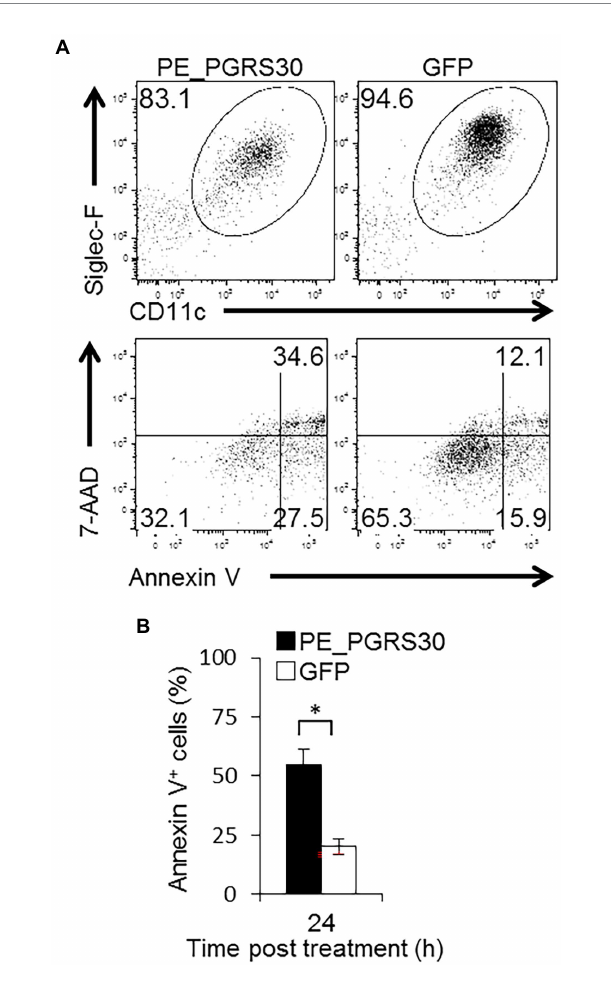
FIGURE 6 Murine alveolar macrophages undergo apoptosis in response to PE_ PGRS30. Bronchoalveolar lavage (BAL) cells were prepared and treated with 10 μ g/ml recombinant PE_PGRS30 and control GFP protein for 24 h. (A) Representative plots of Siglec-F + CD11c + cells (AMs, upper panel) and annexin V + cells in AMs (lower panel) are presented. (B) Numbers of annexin V + cells are presented as percentages of total AMs. More than 10 4 BAL cells were analyzed in each experiment. Data are representative of three independent experiments. Means ± SD are shown. * p < 0.05 using Student’s t